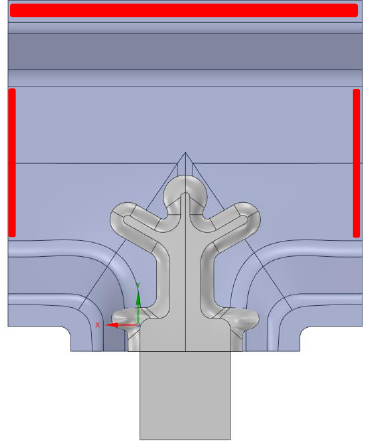
Figure 2. Fixed areas of the structure in